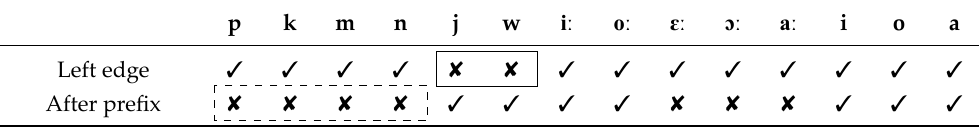
Table 5. Segments allowed at left edge of roots in two